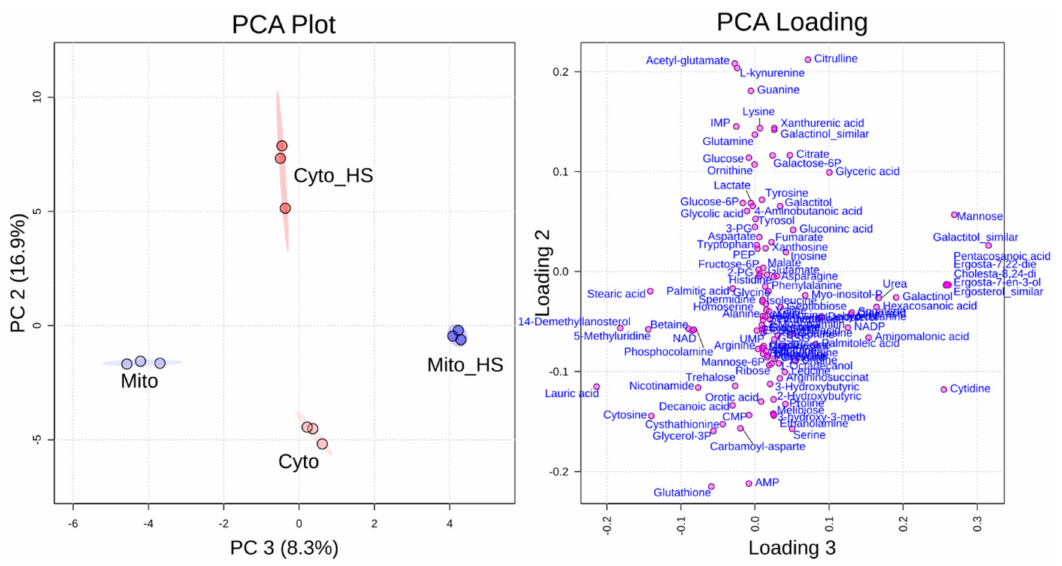
Figure 1. Principal component analysis (PCA) and loading plot. PCA (left) could separate metabolite levels of mitochondria (Mito) from mitochondria isolated after heat stress (Mito_HS) in component 3 and metabolite levels of the cytoplasm (Cyto) from cytoplasm isolated after heat stress (Cyto_HS) in component 2. PCA loading (right) shows how the single metabolites contributed to the separation of each